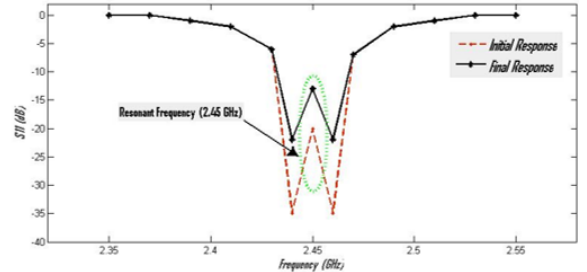
Fig. 10. The photograph of our proposed of 3 r d order dipole antenna